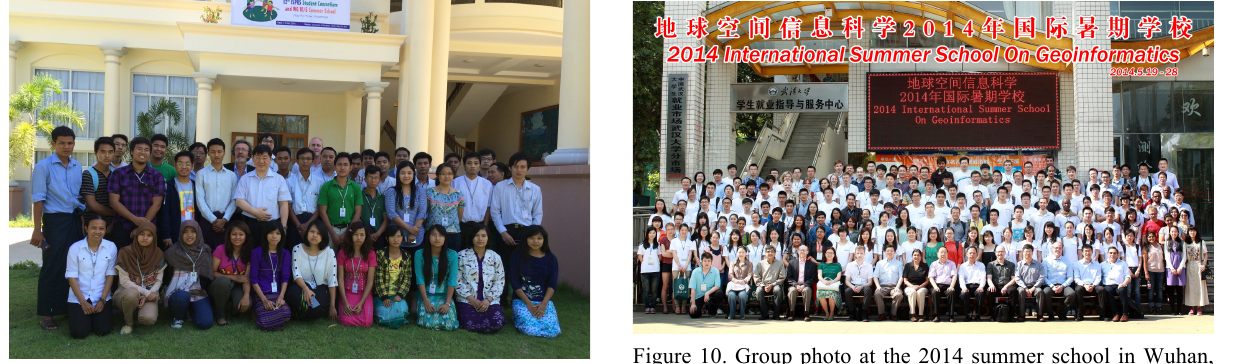
Figure 8. Group photo at the 2014 Myanmar summer school.